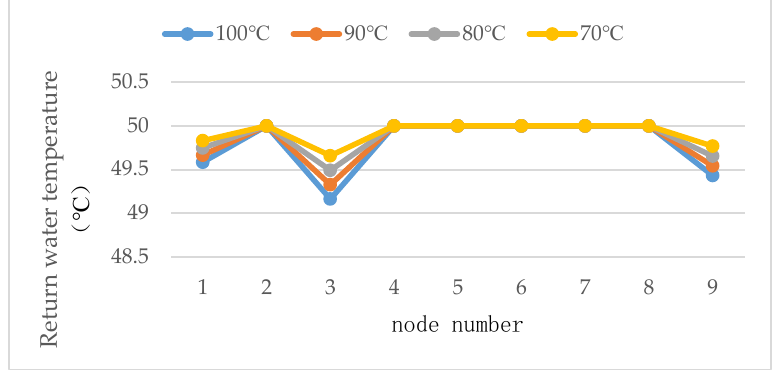
Figure 10. Return water temperature of all nodes under different source-node supply water temperatures.